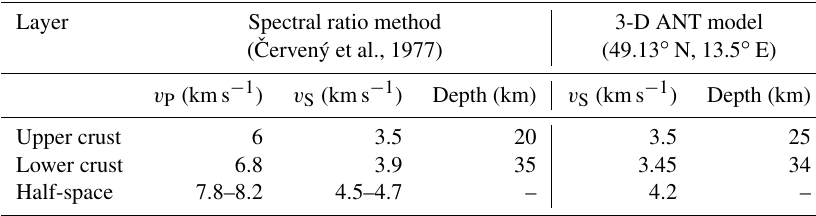
Table 2. Models of the crust beneath the KHC station (Moldanubian